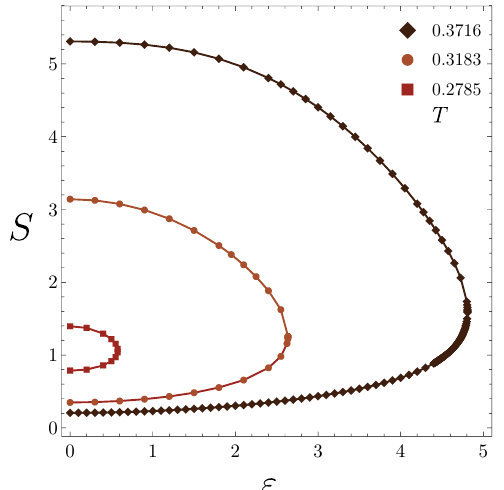
Figure 20 . Entropy vs the boundary rotation parameter, when the metric is adjusted so that there is no ergoregion on the boundary. We observe two branches of black hole solutions which join up at some maximum value of "